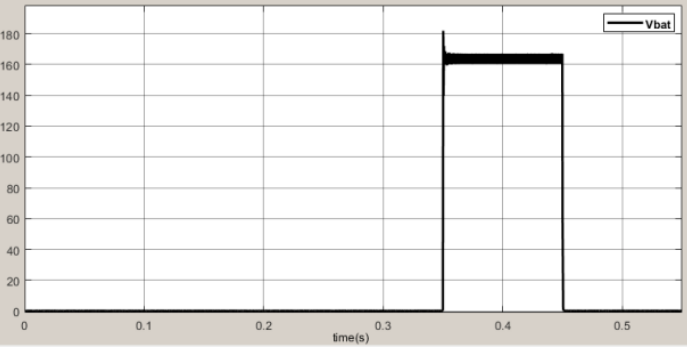
Figure 13. The output during state switching and its sequence: ( a ) voltage waveform of operating state switching; ( b ) current waveform of operating state switching; ( c ) switching sequence of oper- ating states.